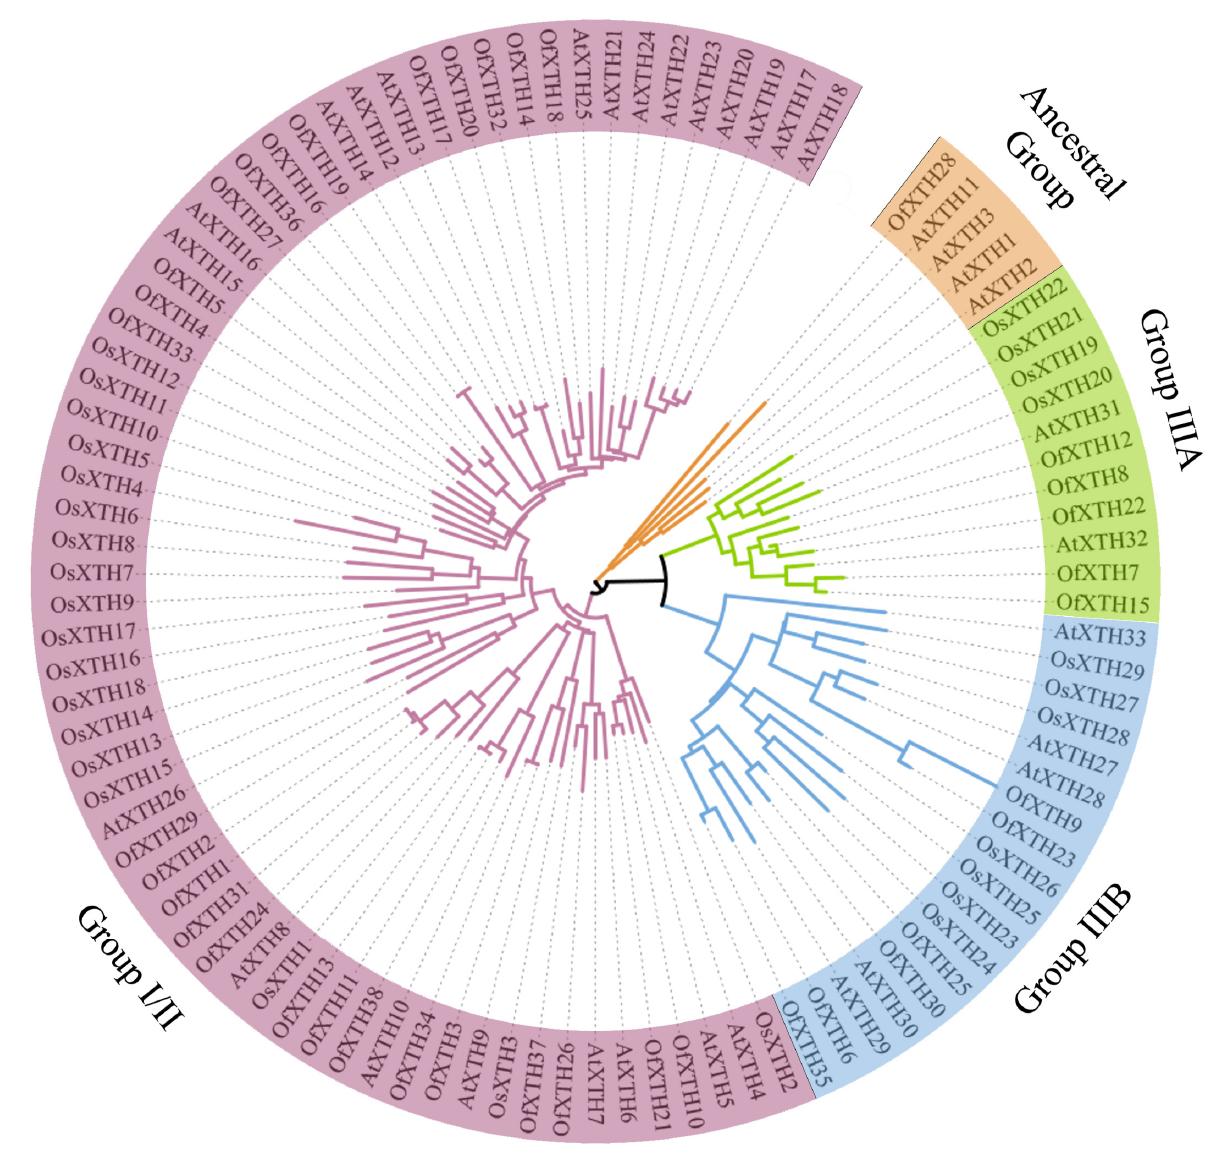
Figure 1. Phylogenetic analysis of XTH proteins from O. fragrans , A. thaliana, and O. sativa . Each subgroup is distinguished by a different